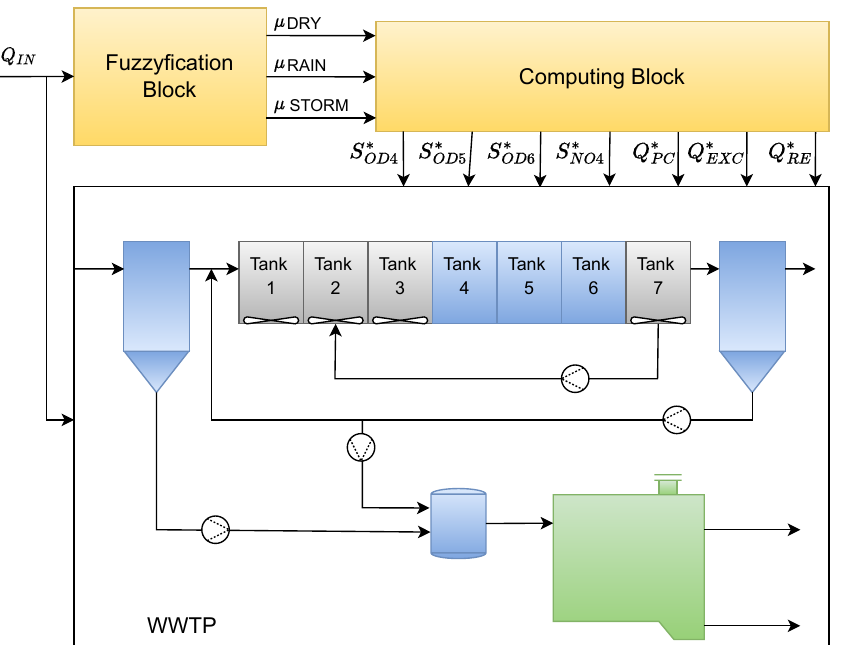
Figure 6. Diagram illustrating the proposed method in